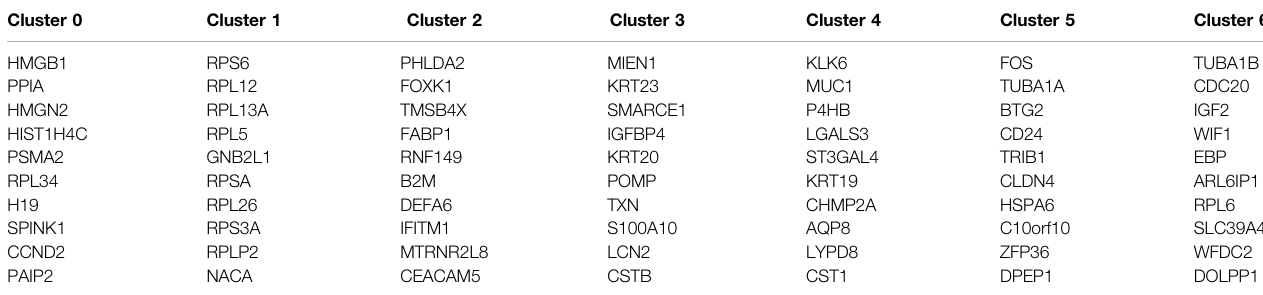
TABLE 1 | The top 10 differentially expressed genes in each subtype. Cluster 0